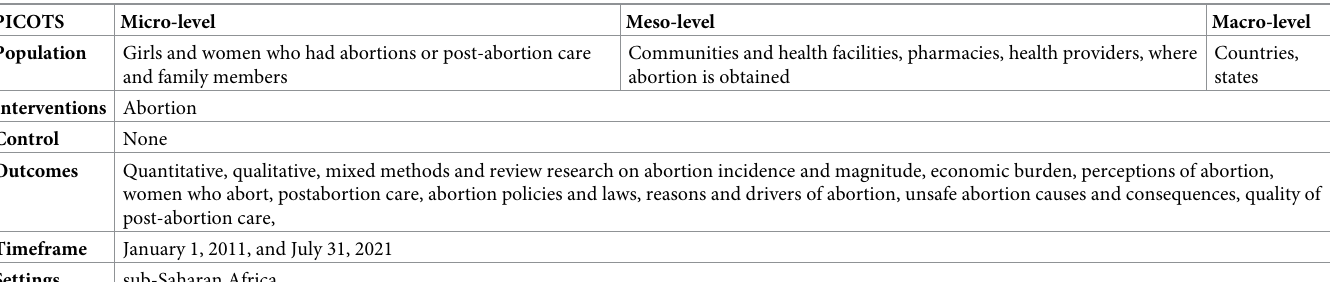
Table 1. PICOTS table summarising our scoping review